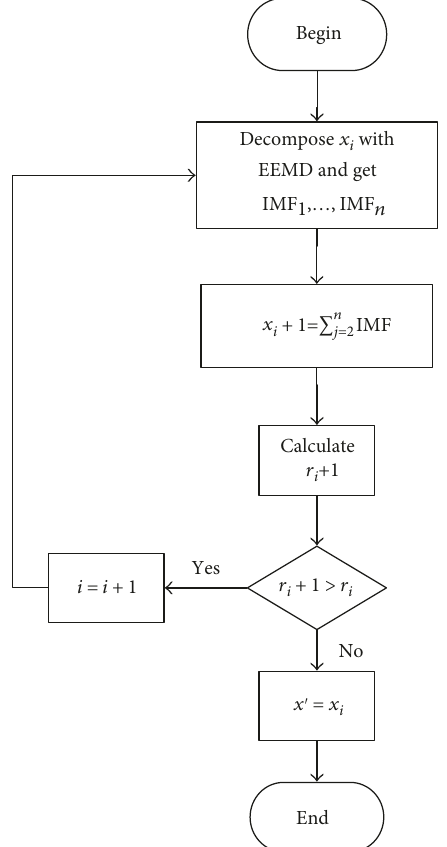
Figure 3: Adaptive EEMD denoising fl ow chart based on normalized index